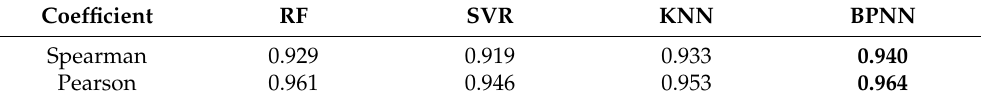
Table 4. Correlation analysis between the model’s prediction score and the doctor’s scale score. Coefficient